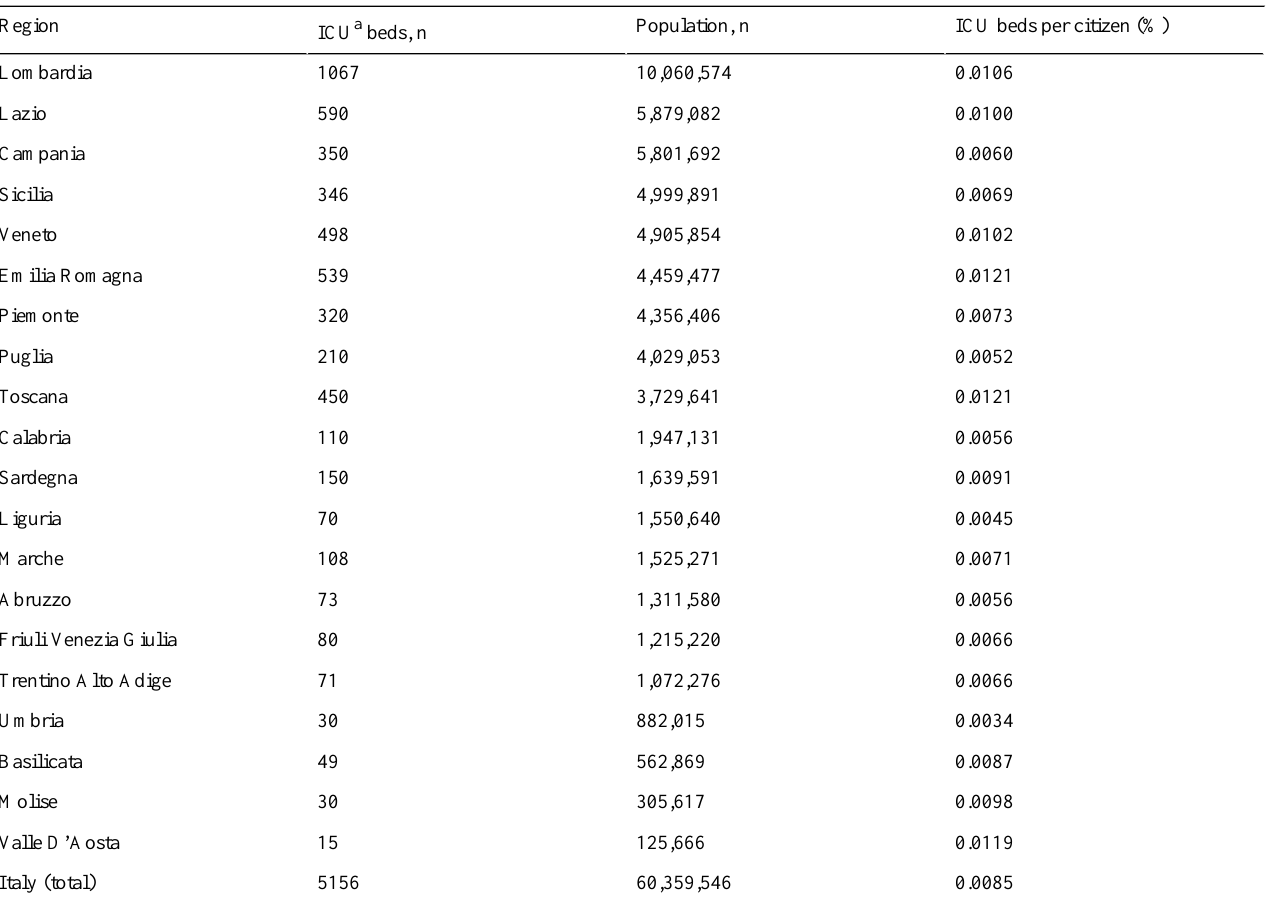
Table 1. Distribution of ICU beds in each Italian region ordered by regional population. The number of beds could increase in the future due to government investments for the